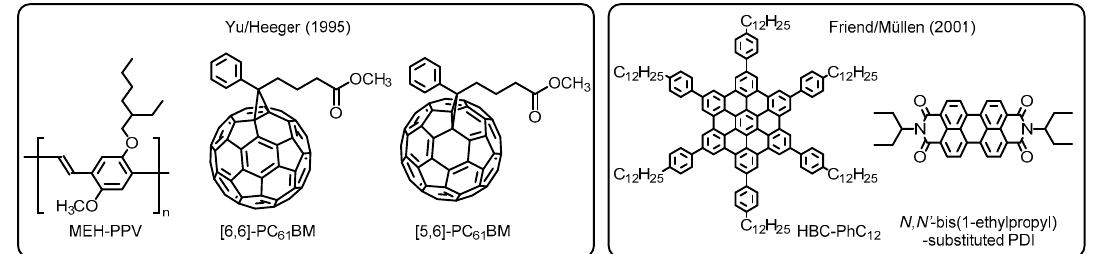
Figure 3. Chemical structures of organic semiconductor materials employed in the primitive OPVs developed by Yu/Heeger and Friend/ Müllen. Adapted from refs